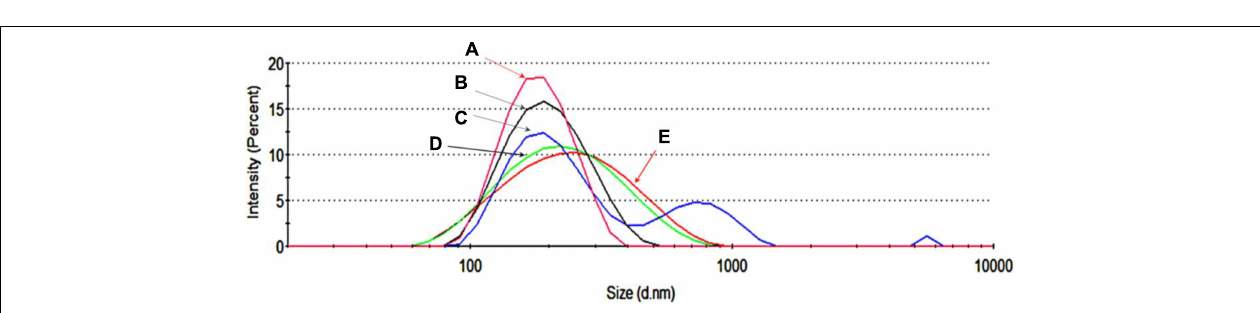
FIGURE 2 | Size distribution and zeta potential of red blood cell-derived extracellular vesicles (RBC-EVs) stimulated by PMA. (A) The highly heterogeneous in size of RBC-EVs, the arrows indicated large particles (cell debris or apoptotic blebs) and fine particles (dust or noise), (B) size distribution by the intensity of EVs collected in the fractions of ultra-centrifuged at 200,000 g for 2 h (overlay of 6 separated measurements), (C) zeta potential distribution of EVs (overlay of 10 separated measurements).